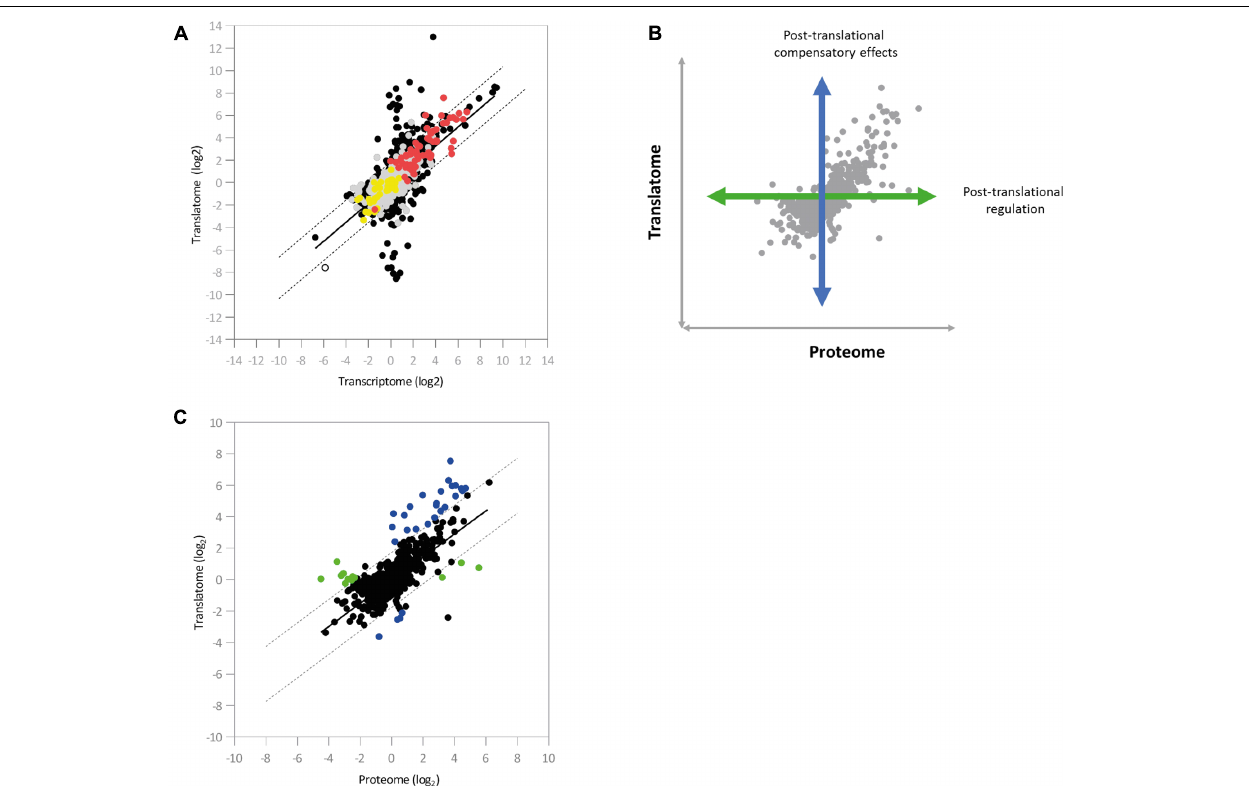
FIGURE 4 | Integration of the regulatory datasets. (A) Color-coded integration of proteomic data into the pairwise comparison between the Hfq transcriptome and translatome ( n = 5910). Red and yellow dots indicate loci that show up- and down-regulated protein abundance, respectively, in the (cid:49) hfq mutant. Loci exhibiting no significant change in protein abundance are indicated in gray ( Supplementary Table S4 ). (B) Illustration of the effects of post-translational control on protein abundance. (C) Scatter-plot showing the pairwise comparisons of log 2 ratios between the (cid:49) hfq translatome and proteome ( n = 1867). Post-translationally regulated loci are marked in green, while loci displaying compensatory post-translational effects are marked in blue ( Supplementary Table S4 ). In both cases, dashed lines indicate two-fold ratios of differential expression from the regression line (in